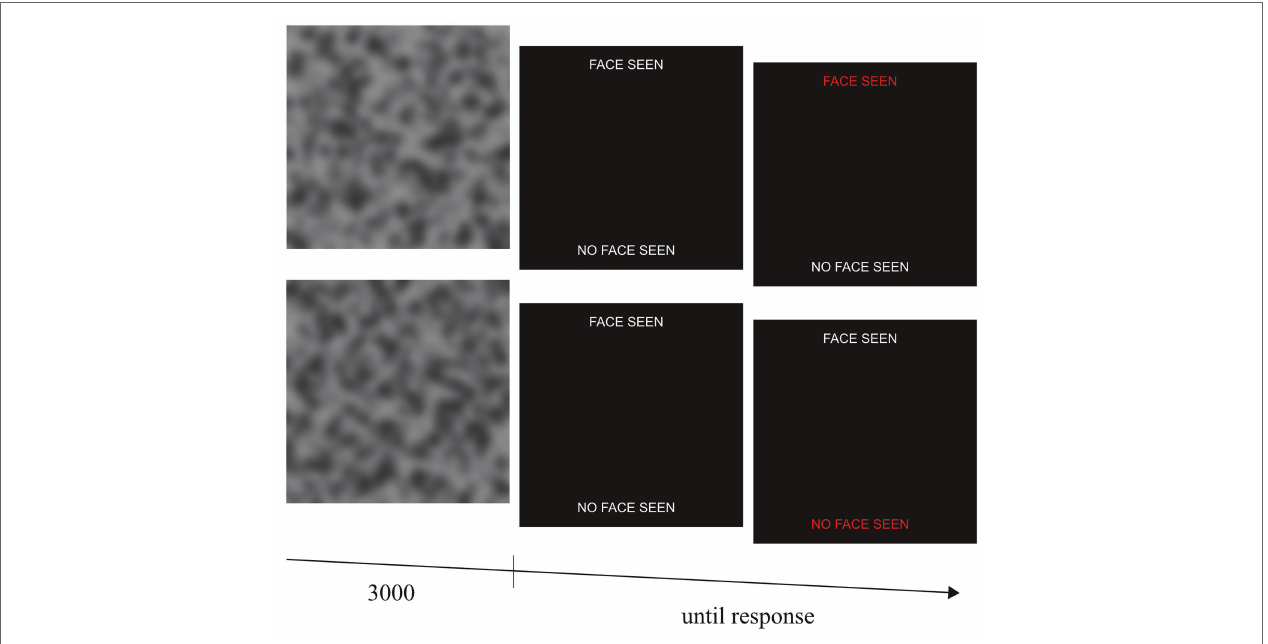
FIGURE 1 | Experimental sequence of the face task for two exemplary trials with (top row) and without (lower row) embedded face. Face images were shown for 3,000 ms followed by a binary forced choice indication of whether a face had been detected by the participants. By fitting a Bayesian model to the individual participants’ behavior, we obtained a measure of the prior for detecting